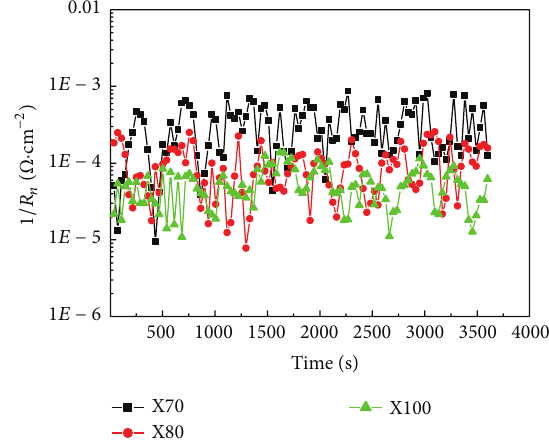
Figure 7: The reciprocal of noise resistance of passive films formed on (a) X70, (b) X80, and (c) X100 pipeline